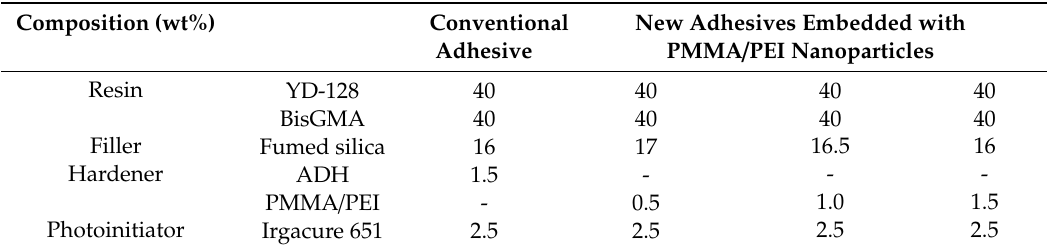
Table 1. Composition of conventional and new UV / heat dual-curable adhesives. Composition (wt%) Conventional New Adhesives Embedded Adhesive